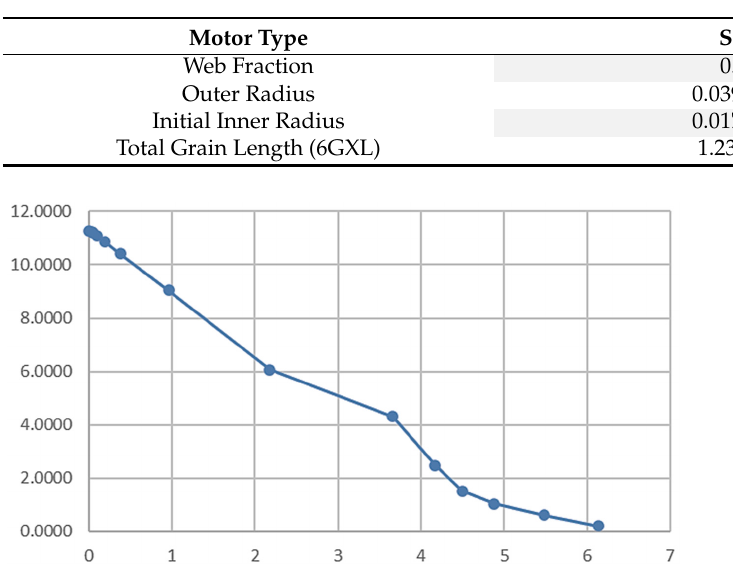
Table 11. Solid motor fuel grain geometry.